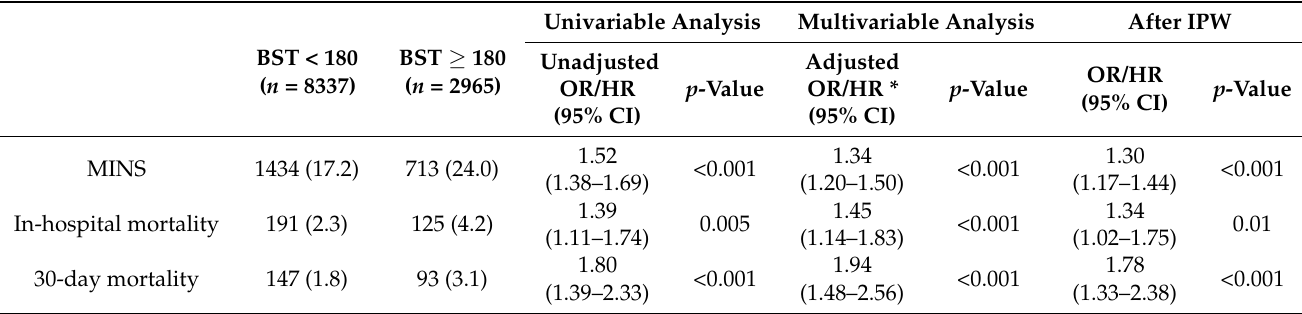
Table 3. The incidence of myocardial after non-cardiac surgery and mortality according to preoperative blood glucose level.